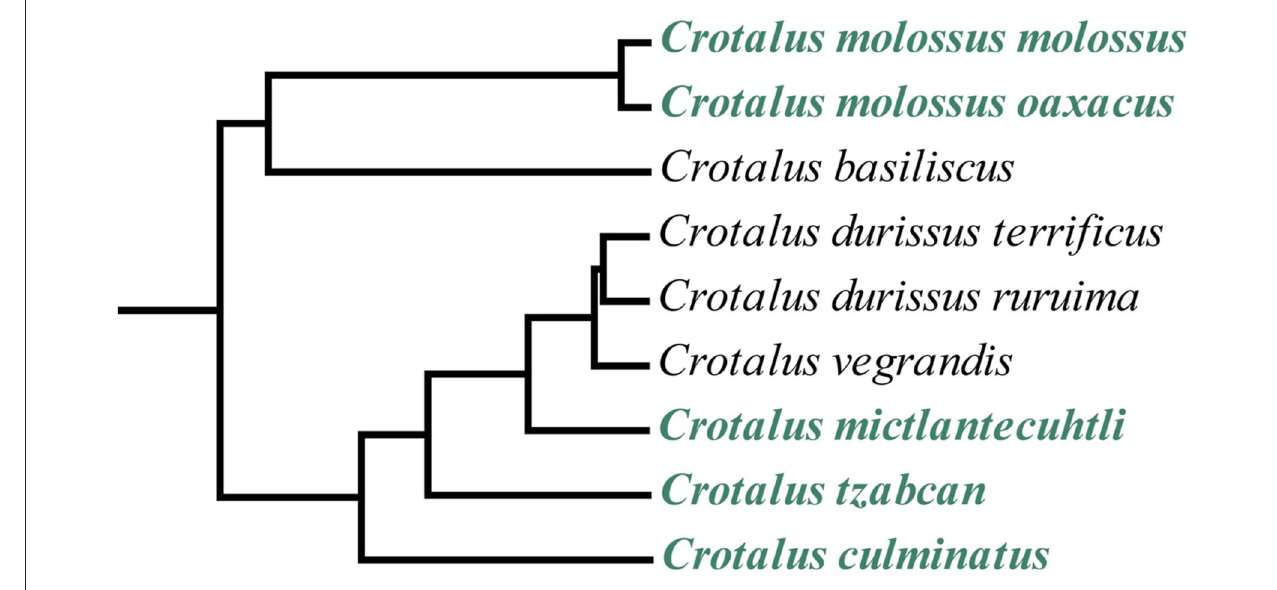
FIGURE 1 | Phylogenetic tree of the Crotalus durissus group from a parallel study (timetree.org) showing the relationships between the C. durissus complex (Neotropical rattlesnakes) and the C. molossus complex. Species analyzed in this study are shown in green. Not all members of the clade are represented in the tree.